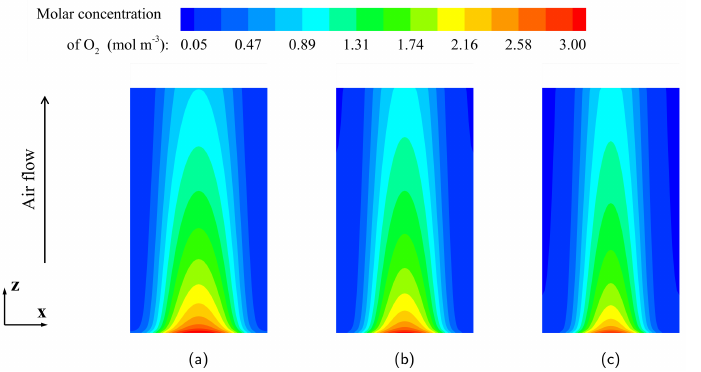
Figure 17. Impact of the LCWR on the oxygen concentration over the middle plane of the CCL: ( a ) LCWR = 0.75. ( b ) LCWR = 1. ( c ) LCWR =